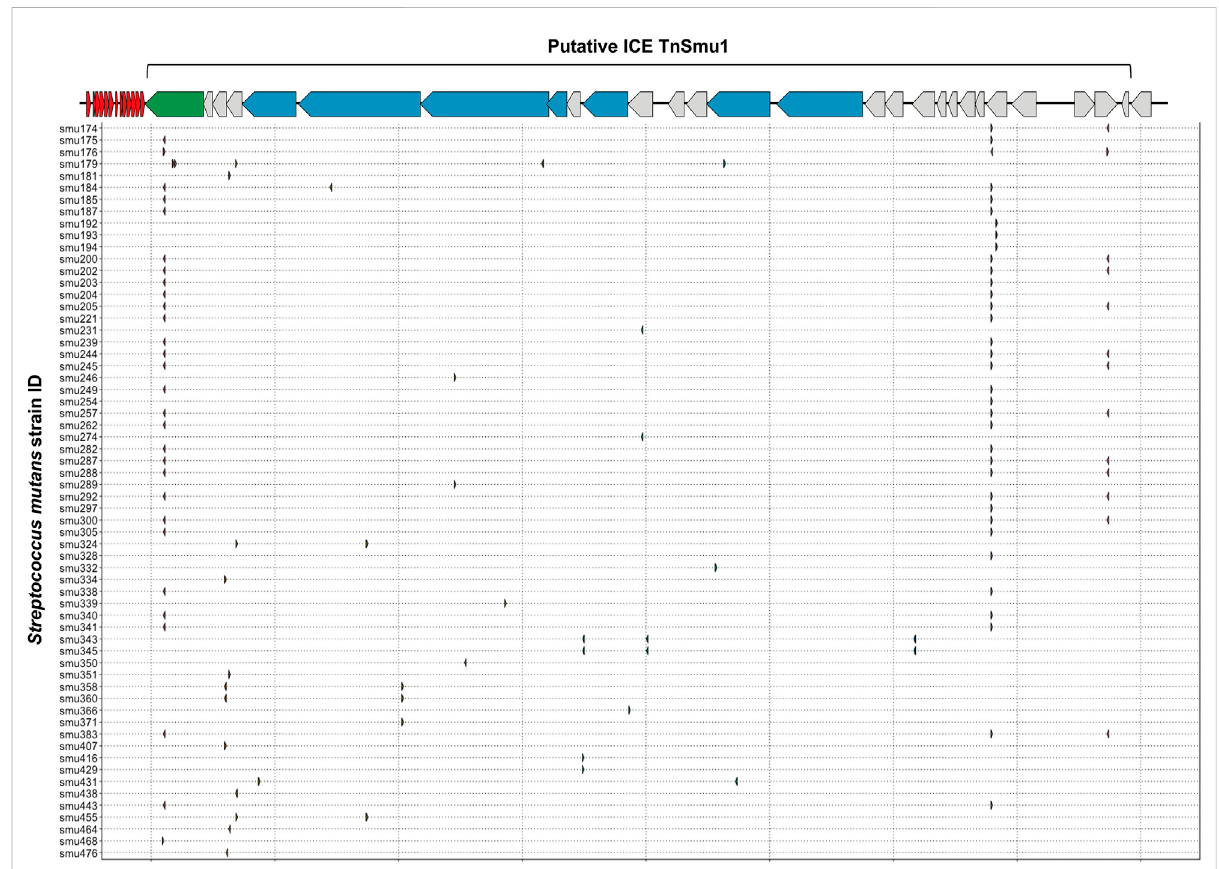
FIGURE 4 CRISPR spacer acquisition against the putative integrative and conjugative element TnSmu1. CRISPR spacers were blasted against ICE sequencesdownloadedfromICEberg.MultipleCRISPRspacersmappedtoaputative S.mutans ICEknownasTnSmu1.Thiselementisapproximately 20 Kbp and consists of twenty-eight genes. Most of the genes are hypothetical (grey) but some are annotated as putative T4SS components (blue) and one gene is annotated as an integrase (green). CRISPRspacers that mapped to thisregion are shown as small arrows, with arow for each S. mutans strain that has acquired spacers against the putative